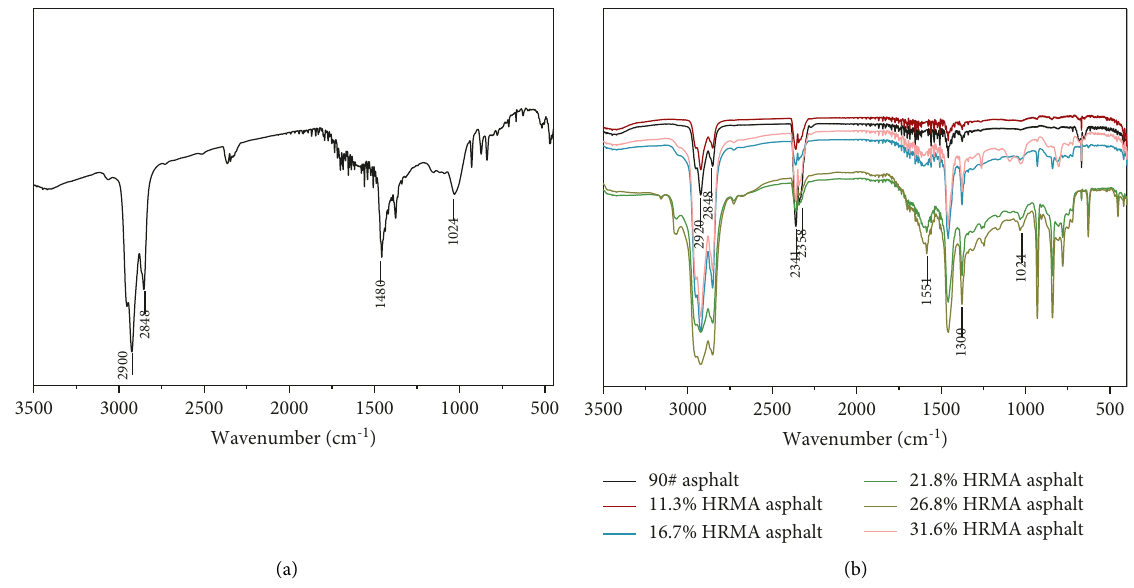
Figure 13: FTIR spectra: (a) HRMA; (b) modified asphalt with different content of